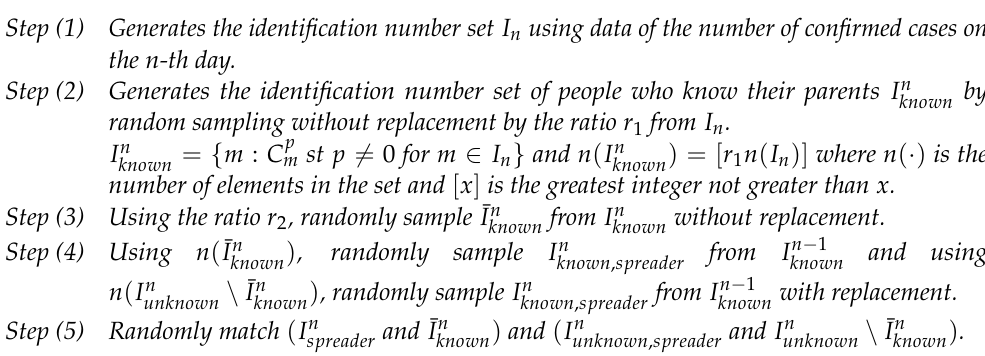
Figure 1. Schematic illustration of the infection routes between the confirmed people. On the first day, people shown in yellow are confirmed as being infected, who infect people the next day. Here, r 1 = 0.7, which is the ratio of people in the blue box to the total number of people on day 1, and r 2 = 0.3, which is the ratio of people in the red box to the total number of people on day 1. The main algorithm for the infection network between confirmed cases is given as